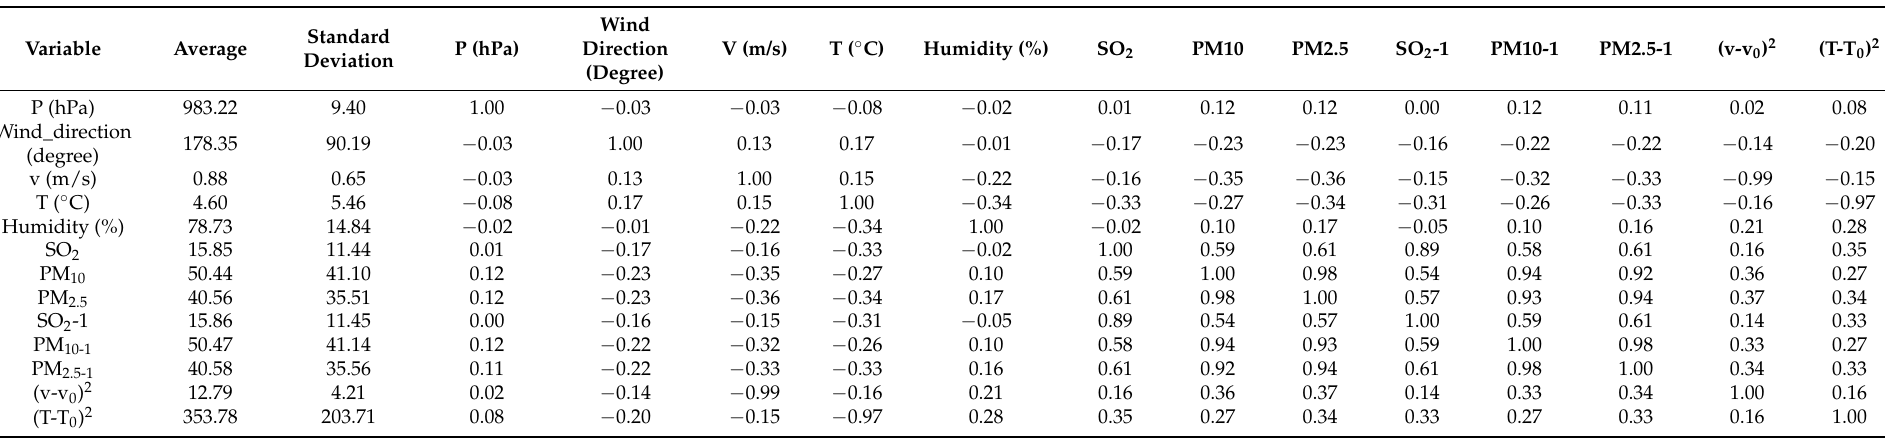
Table 3. Correlation coefficients for values measured at the station in Katowice in the years 2013–2016 (Kossuth street, N =